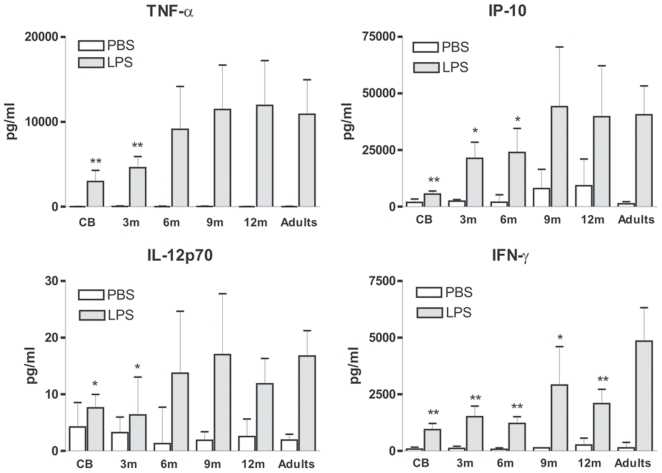
Age-dependent upregulation of LPS-induced production of TNF-α, IP-10, IL-12p70 and IFN-γ.Whole blood samples were stimulated with LPS and culture supernatants were collected after 16–18 h. Production in the different infant groups was compared to adult values. Cord blood (CB, n = 13), 3-month (3 m, n = 15), 6-month (6 m, n = 8), 9-month (9 m, n = 9), 12-month (12 m, n = 9) old infants and healthy adults (n = 10). Data are represented as median+interquartile range. *p<0.05, **p<0.01, ***p<0.001 as compared to stimulated adult samples.